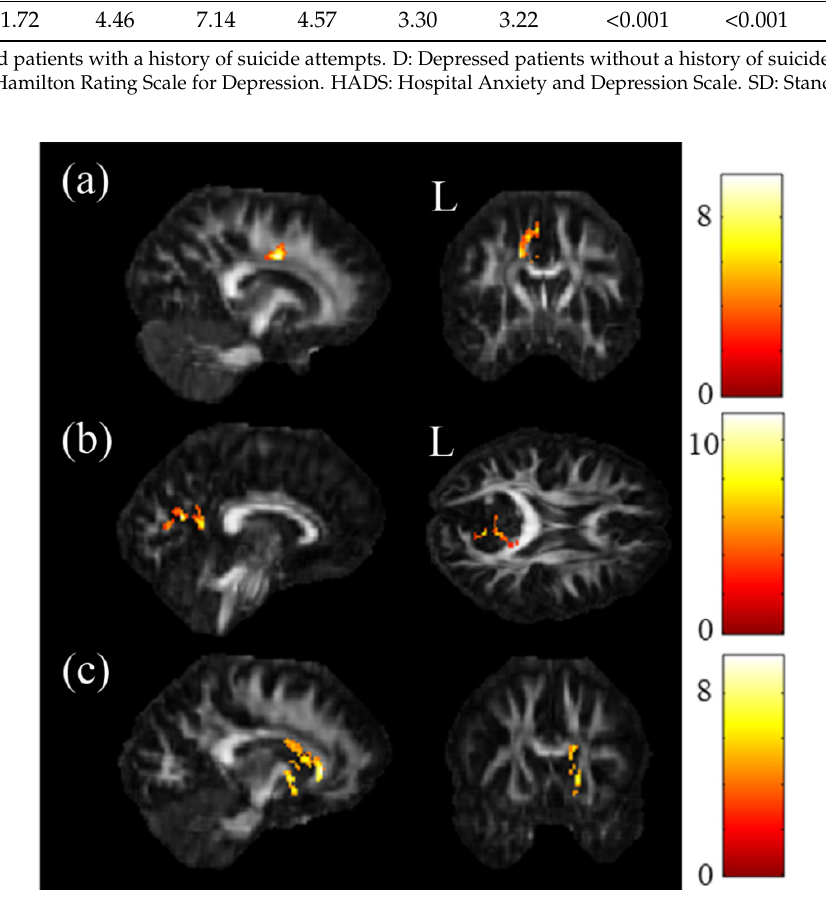
Figure 1. ANCOVA results of generalized fractional anisotropy (GFA) and normalized quantitative anisotropy (NQA). Significant results were demonstrated in the ( a ) cingulate gyrus and the ( b ) precuneus of GFA value and in the ( c ) cingulate gyrus and the caudate of NQA value ( p < 0.05, cluster size > 100, color bar: F scores).